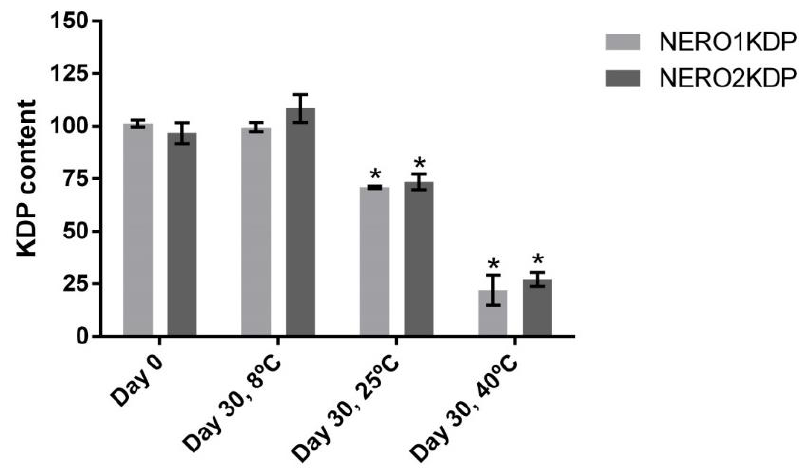
Figure 2. Kojic dipalmitate (KDP) content in 1 mg/mL (NERO1KDP) and 2 mg/mL (NERO2KDP) KDP-loaded nanoemulsions after 0 and 30 days of storage at 8, 25, and 40 °C. An asterisk indicates a significant difference between NERO1KDP or NERO2KDP and the same formulation on day 0 of storage ( p ≤ 0.05).